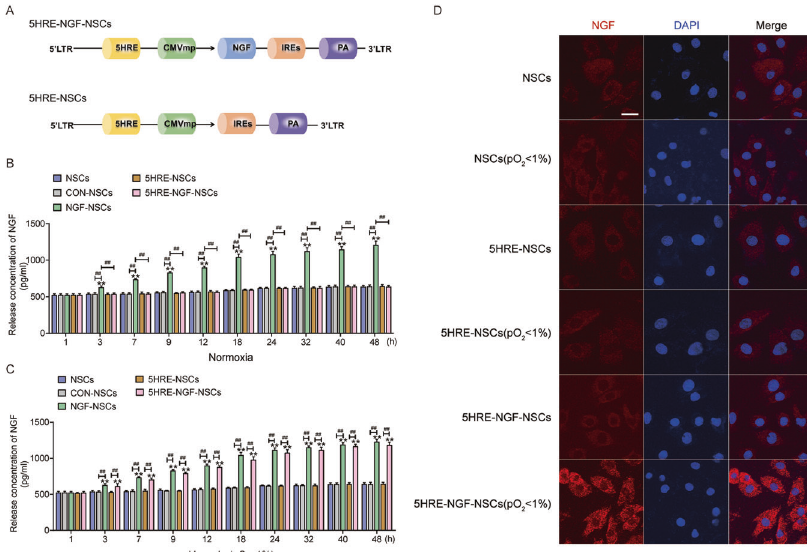
Fig. 1 The establishment and authentication of adeno-associated virus-II loaded 5HRE-NSCs and 5HRE-NGF-NSCs. A A schematic plot of constructs of adeno-associated virus-II loaded 5HRE-NSCs and 5HRE-NGF-NSCs. B , C Release concentration of NGF under control and hypoxia (pO 2 < 1%) conditions. Levels of NGF exhibited by ELISA. ** notes P < 0.01 versus NSCs group, ## notes P < 0.01 and # notes P < 0.5. Data are the mean values ± SD, n = 6. D Staining of NGF and nucleus, in NSCs, 5HRE-NSCs, 5HRE-NGF-NSCs and corresponding hypoxia (pO 2 < 1%) groups, showing the NGF (red), nuclei (blue) in vitro. Scale bar = 50 μ